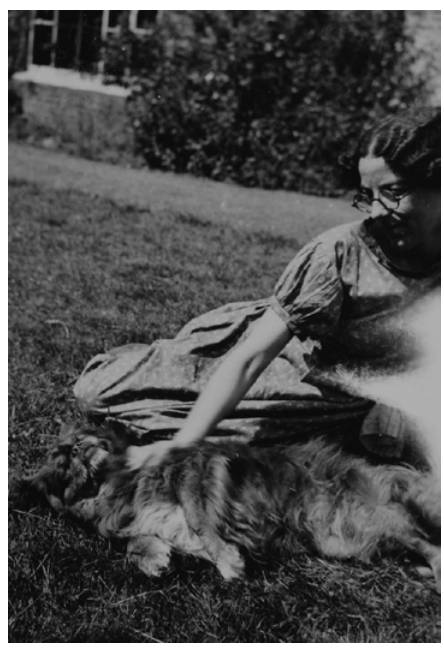
Figure 1. ‘My dear, my true Thomas’. Page from St Valentine’s Day booklet handmade by Valentine Ackland for Sylvia Townsend Warner, 14 February 1948. Reproduced with permission from the Sylvia Townsend Warner Archive at the Dorset History Centre: STW: H(R)/5/30; in box